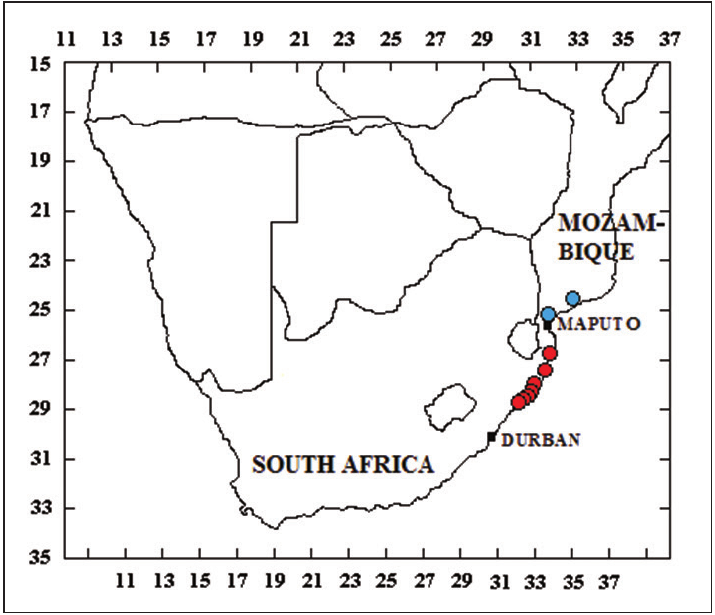
Figure 6. Known distribution of Lamellothyrea descarpentriesi (blue circles) and L. isimangaliso sp. n. (red